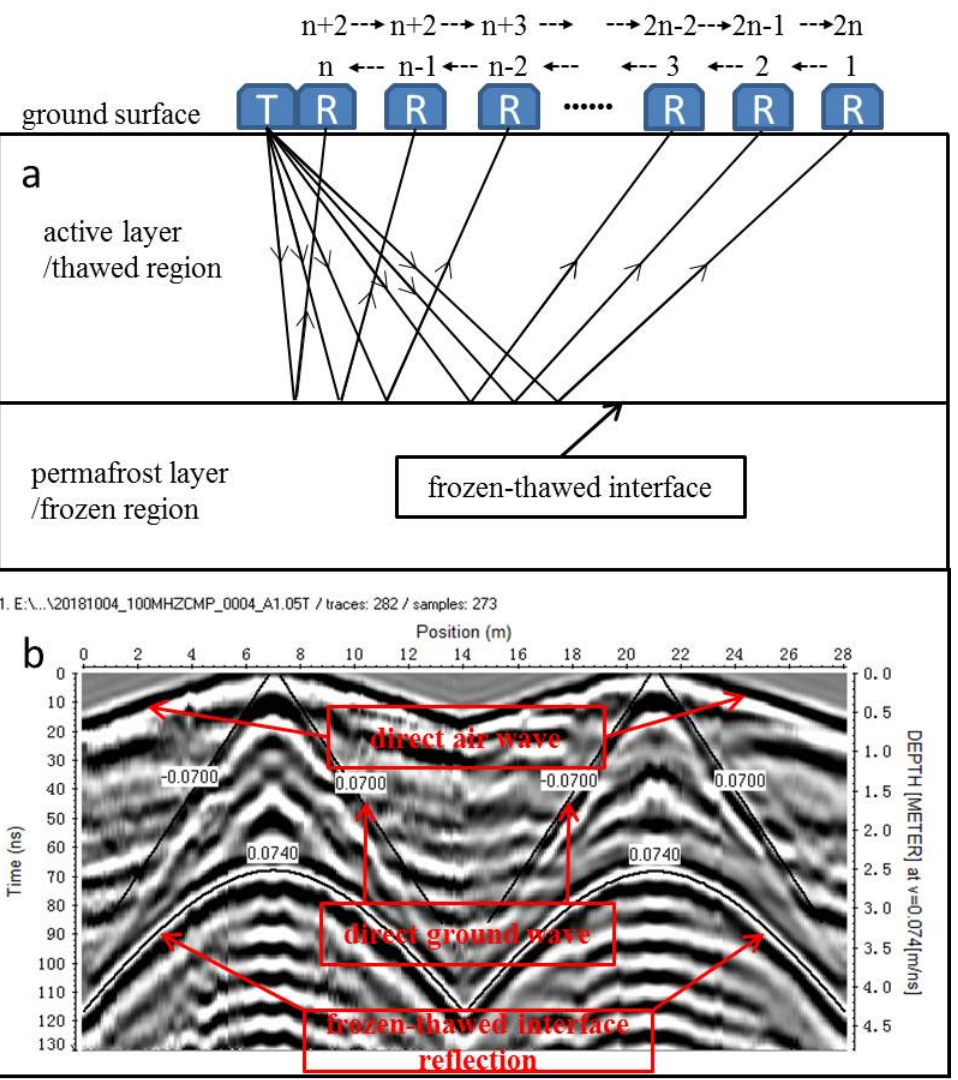
Figure 2. ( a ) Schematic diagram of back–forward wide-angle reflection and refraction (BFWARR) detection; ( b ) real BFWARR detection GPR data and the identified characteristics of the direct air wave, direct ground wave, and reflecting wave.